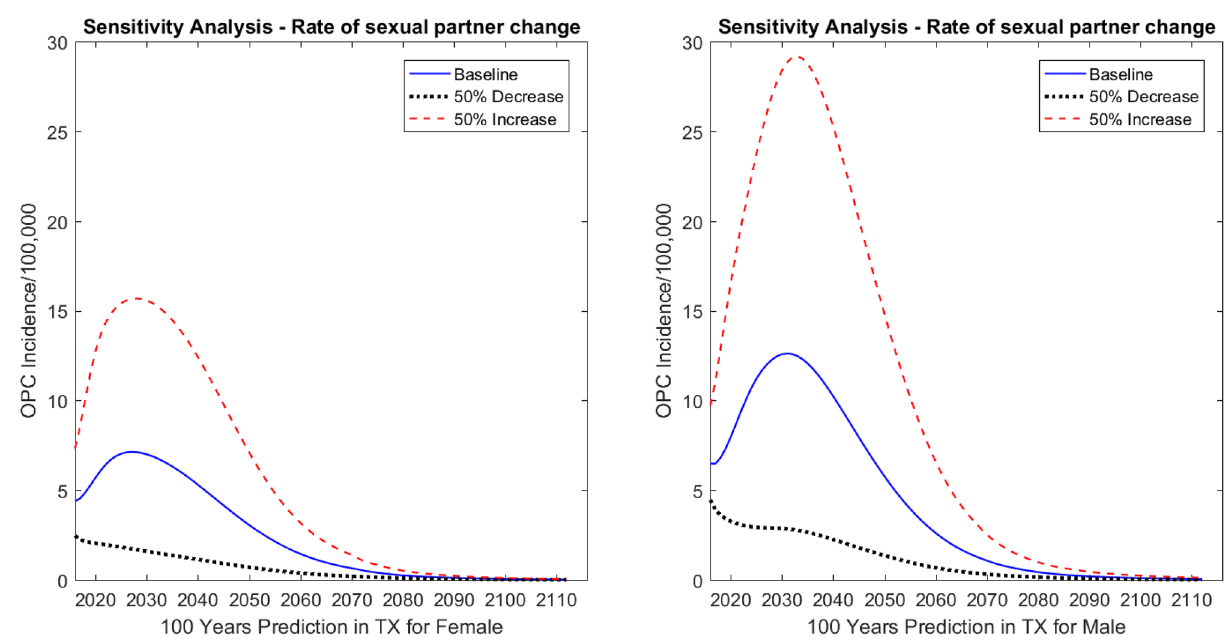
Figure 5. Sensitivity analysis: predicted effect of rate of sexual partner change on oropharyngeal cancer (OPC) incidence in Texas (TX). The graph on the left shows predictions for females; the graph on the right shows predictions for